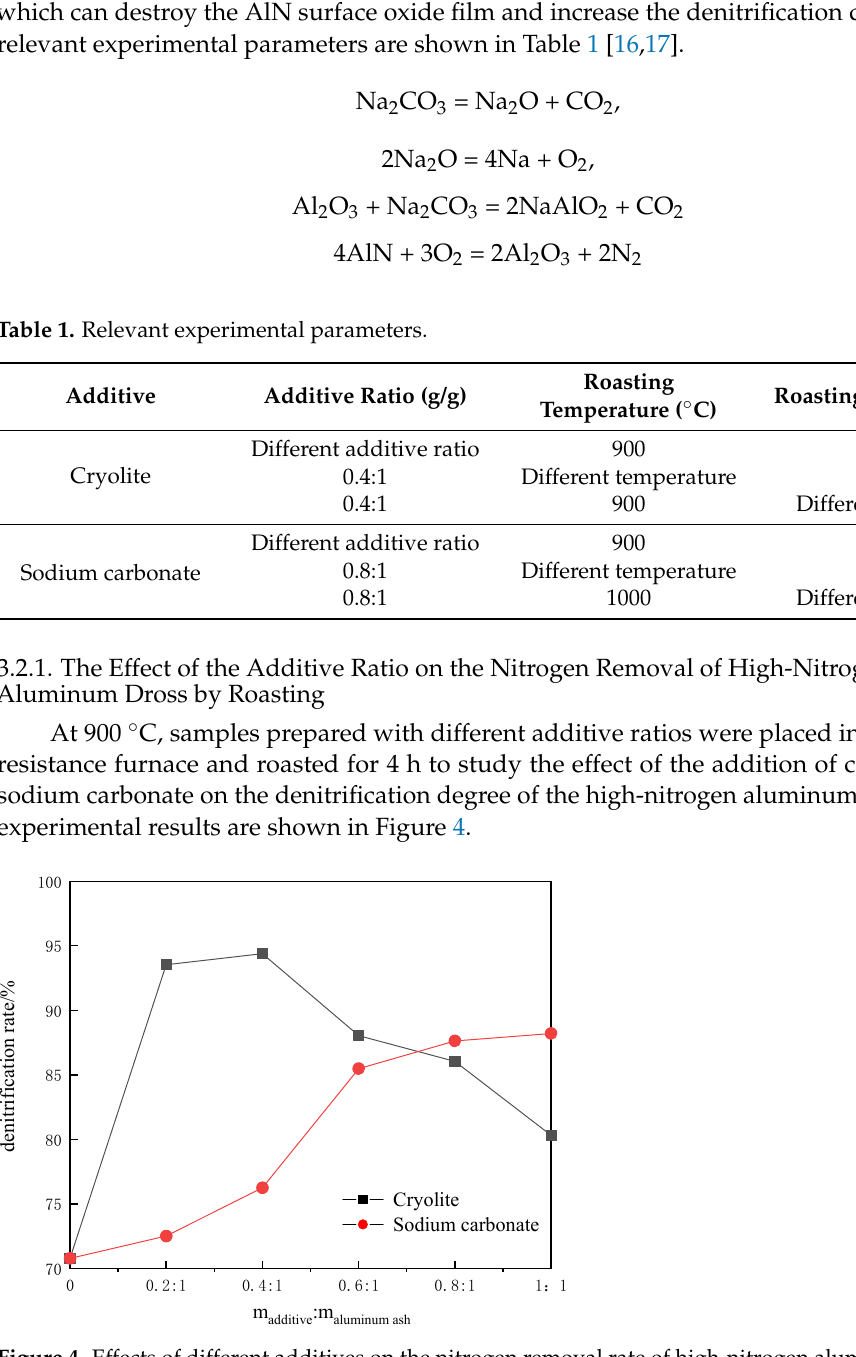
Figure 4. Effects of different additives on the nitrogen removal rate of high-nitrogen aluminum dross.